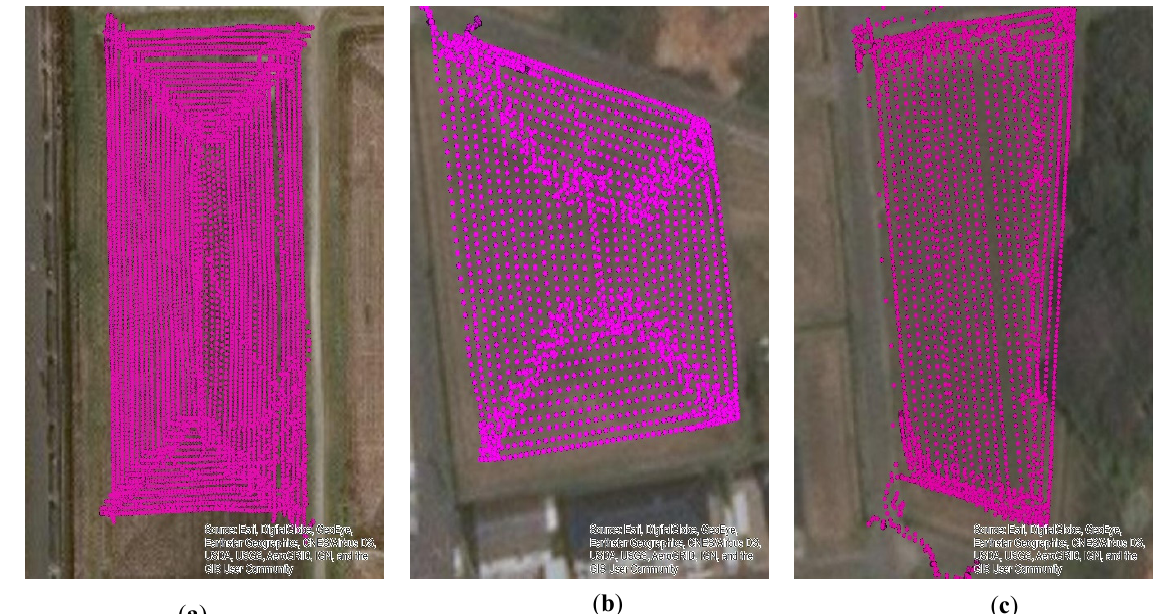
Figure 3. Harvesting tracks: ( a ) Plot 1 at Gifu University; ( b ) Plot 2 and ( c ) Plot 3 at Kaizu.